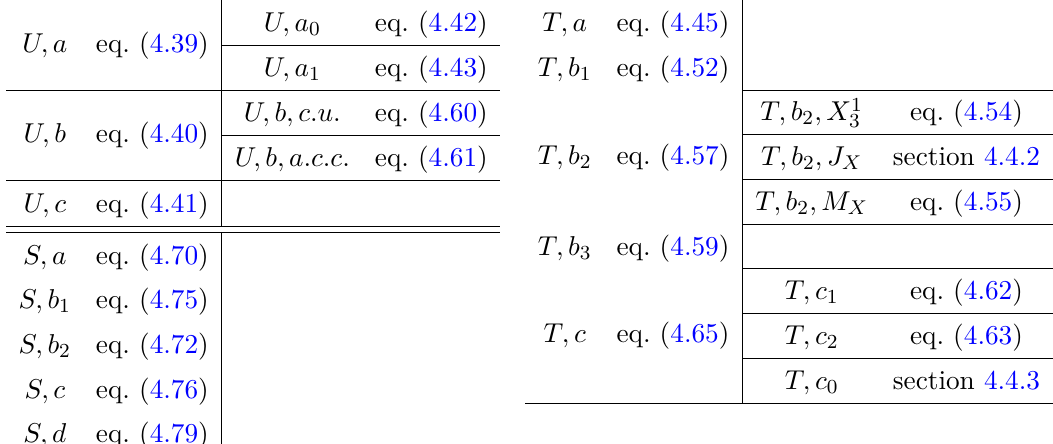
Table 2 . Definitions of each term appearing in figure 1.